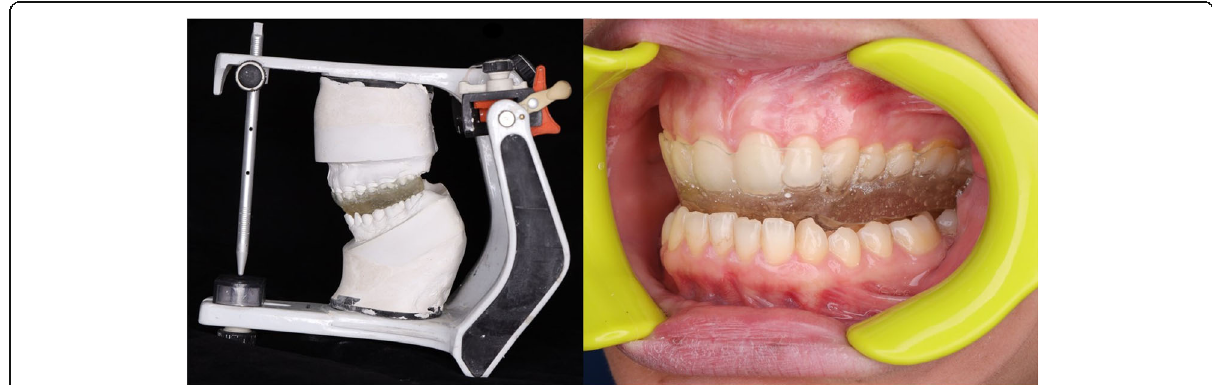
Fig. 3 Left: Fabrication of the anterior positioning splint on a semi-adjustable articulator to achieve an anterior mandibular position which eliminates the click. Right: Intraoral photograph of finished splint in position and the anterior mandibular position